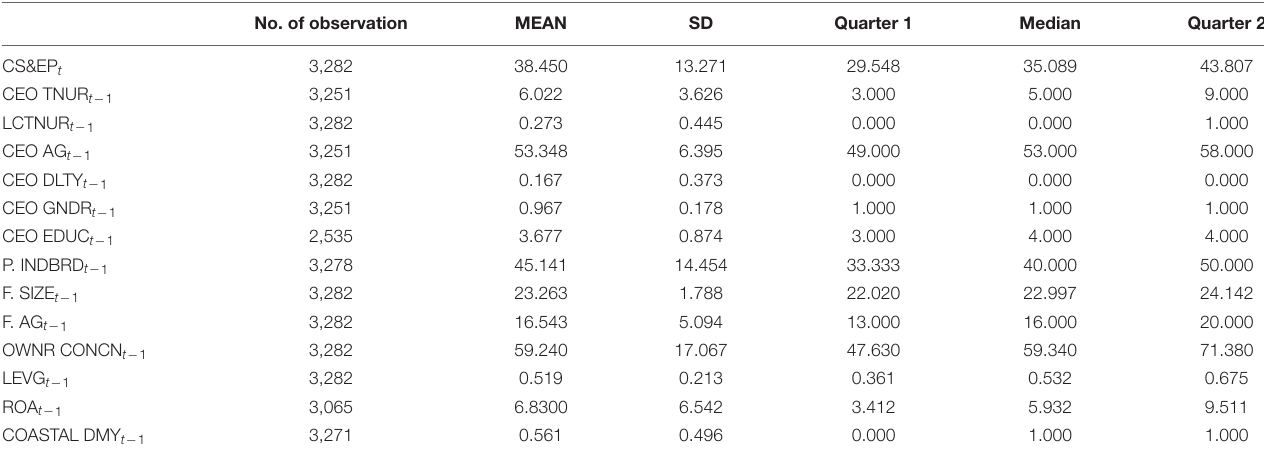
TABLE 2 | Descriptive